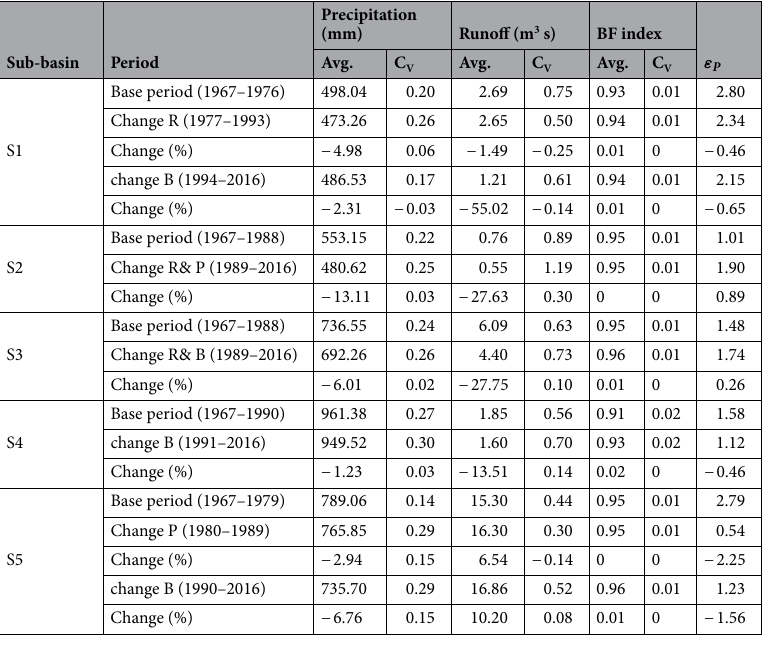
Table 7. Calculation variation of precipitation, runoff, BFI index, and elasticity estimation.